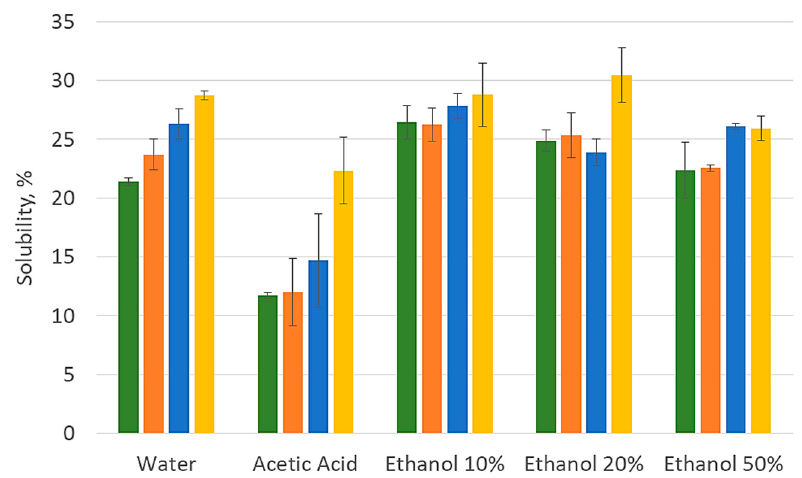
Figure 5. Solubility of films in food simulants ( (cid:4) —CH 2% films; (cid:4) —CH 2% + OLE 10% films; (cid:4) —CH 2% + OLE 20%; (cid:4) —CH 2% + OLE 30%).